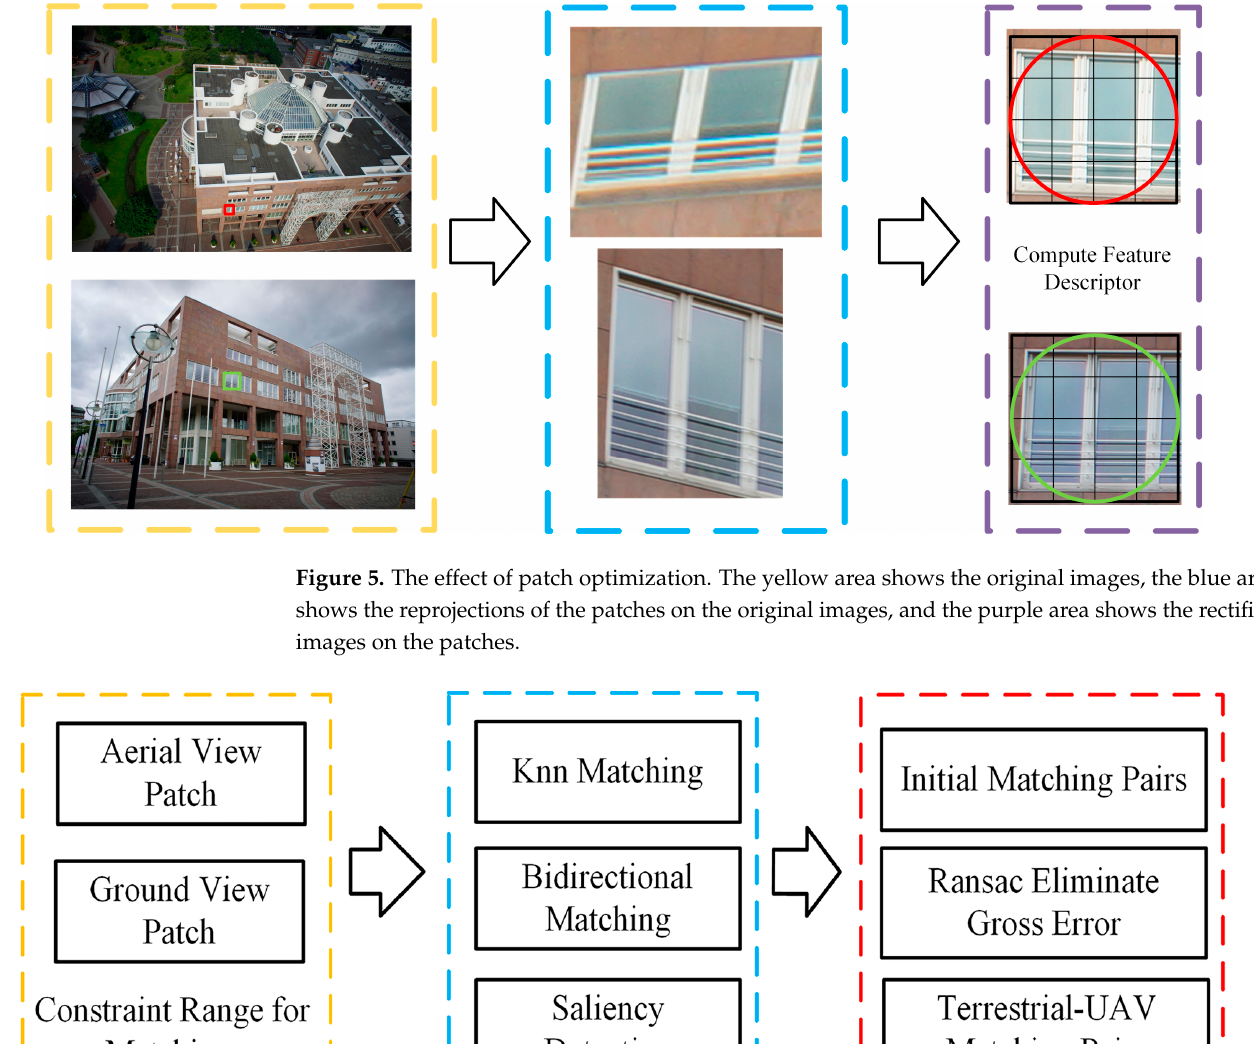
Figure 5. The effect of patch optimization. The yellow area shows the original images, the blue area shows the reprojections of the patches on the original images, and the purple area shows the recti- fied images on the patches.